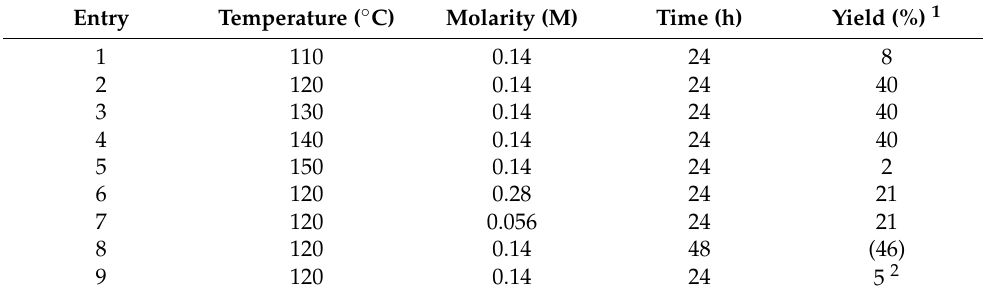
Table 1. Effect of reaction conditions on the formation of sulfide 1 by the reaction between diphenyliodonium triflate and anhydrous DMSO.